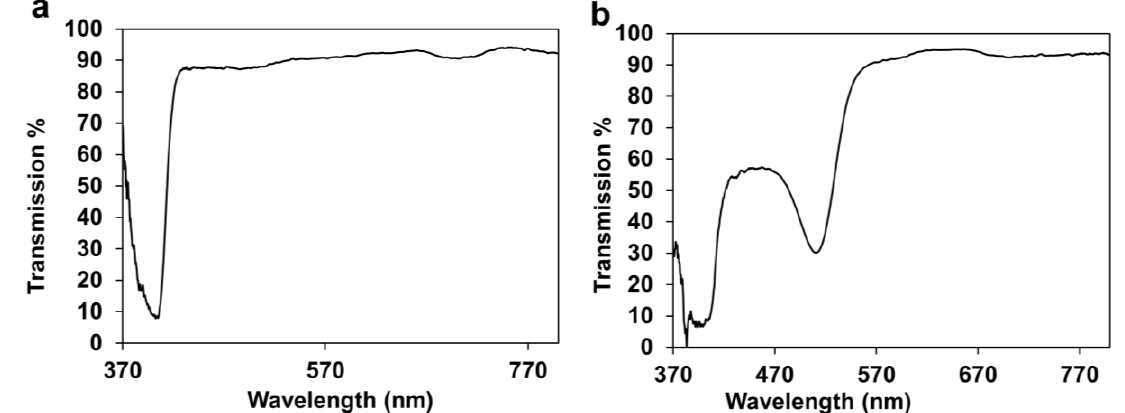
Figure 1. ( a ). Optical transmission of 3D printed HEMA/PEGDA/TPO/AA . ( b ) Optical transmission of 3D printed HEMA/PEGDA/TPO/AA-PR .